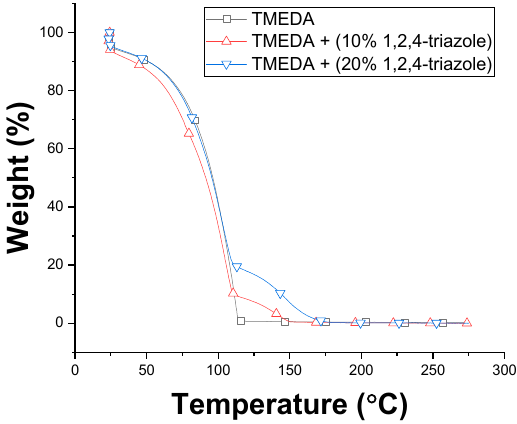
Figure 3. Temporal change of reduced fuel mass with temperature profile.